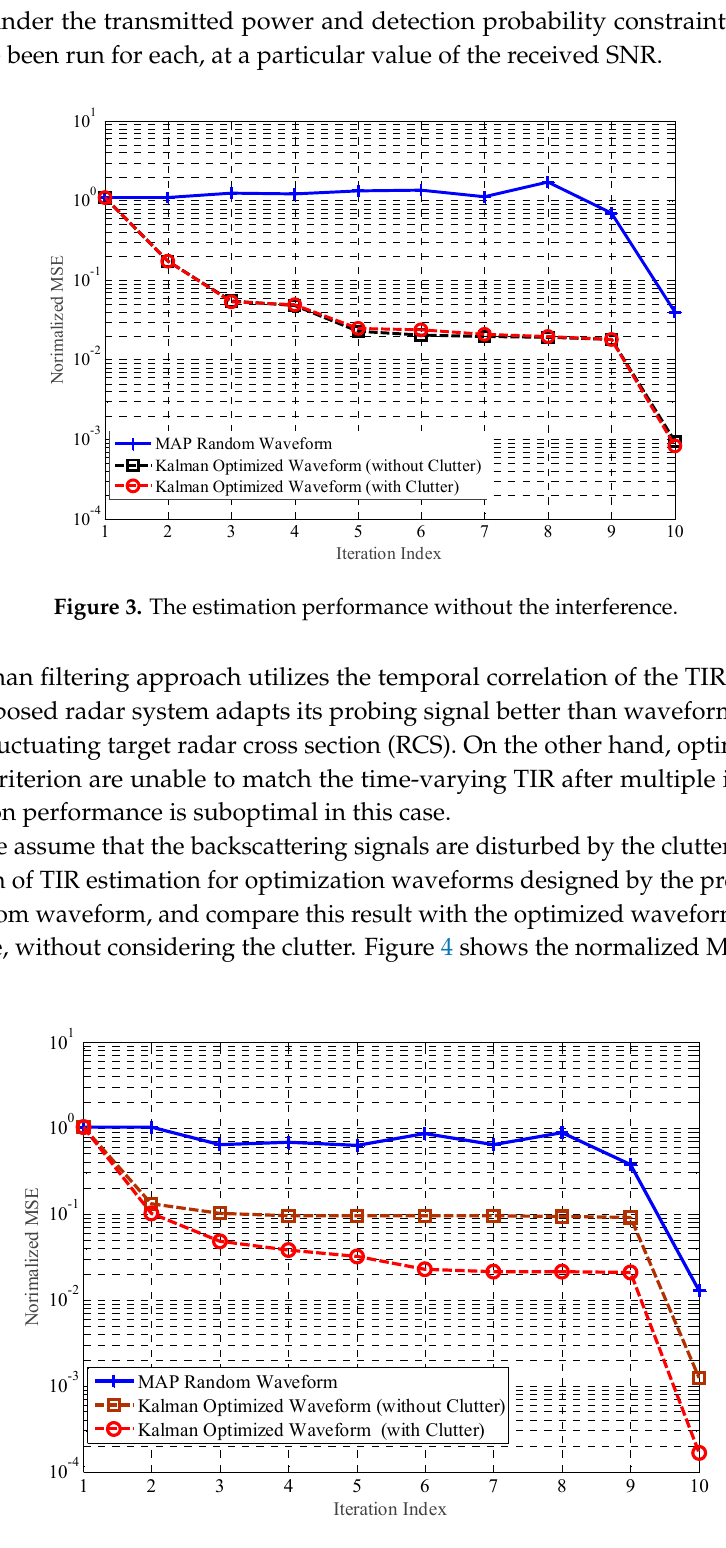
Figure 4. The estimation performance with the interference.